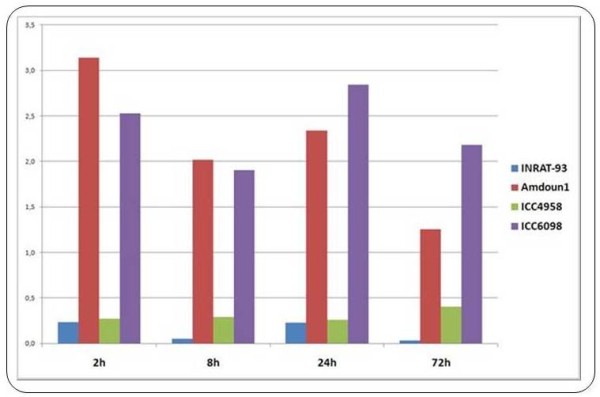
Relative expression levels of a lipoxygenase-annotated transcript in four chickpea varieties at different time points after salt stress onset, measured by qRT-PCR. Transcript levels of chickpea 26 bp tag STCa-7252, annotated to a lipoxygenase gene, remained constant 2 h hours after salt stress onset in INRAT-93 according to deepSuperSAGE. When compared to the transcript levels of other chickpea varieties, strong differences are observed. The two less salt-tolerant varieties Amdoun1 and ICC6098 show a much higher expression level over time.